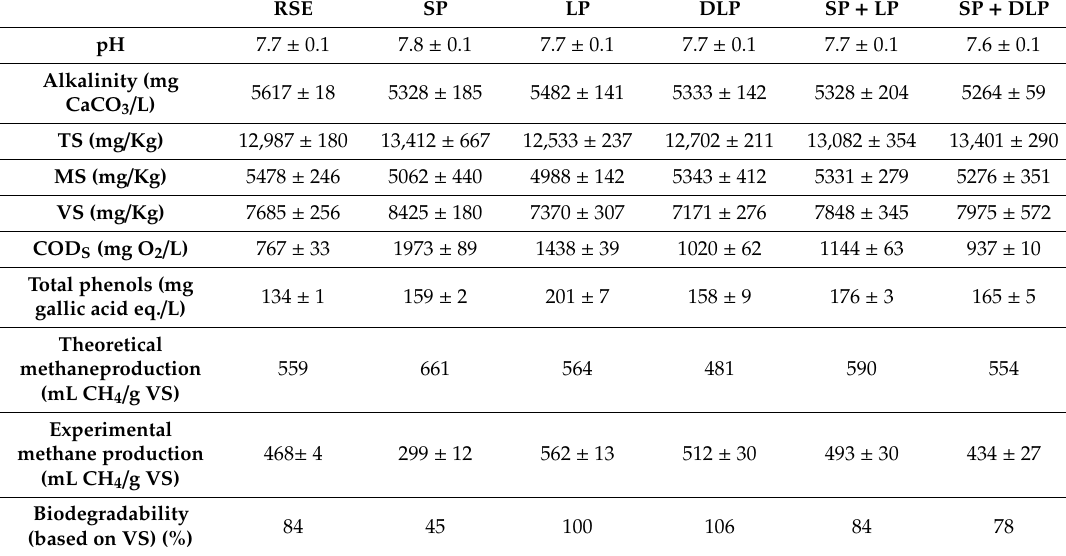
Table 4. Analytical characterization of e ffl uents from the anaerobic digestion processes at the end of the BMP tests (after treatment at 220 ◦ C) with their standard deviations.